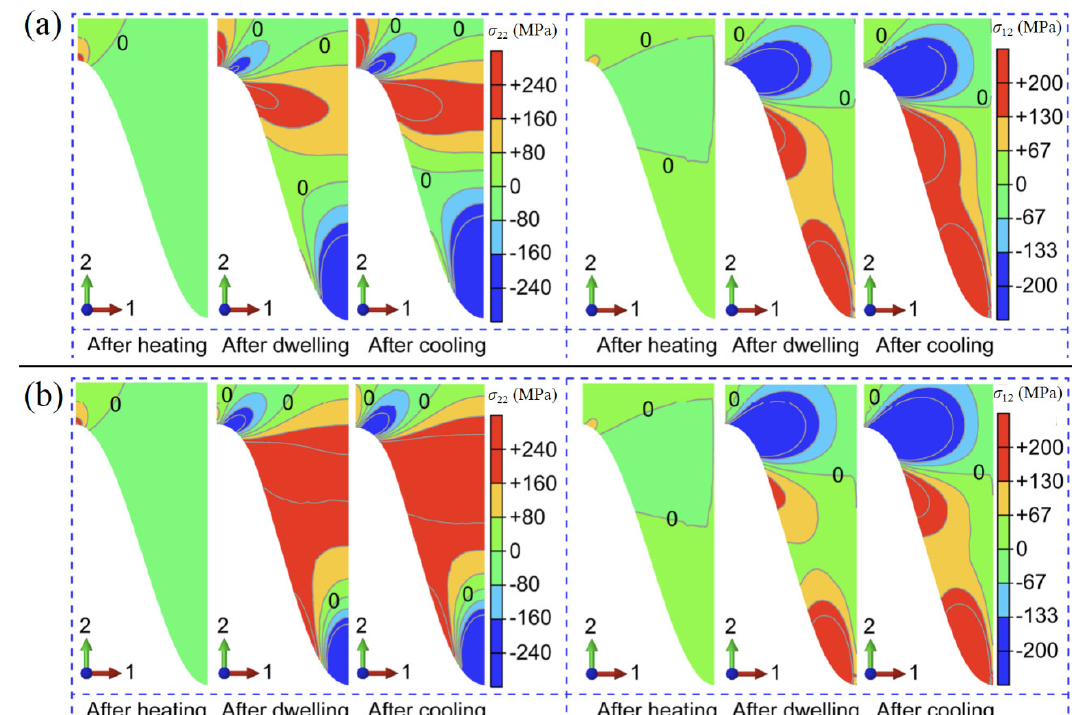
Fig. 39 Distributions of the residual normal (left) and shear (right) stresses in the TC under different TGO growth conditions: (a) only with TGO thickening growth and (b) with TGO thickening and lateral growth. Reproduced with permission from Ref. [133], © ASM International